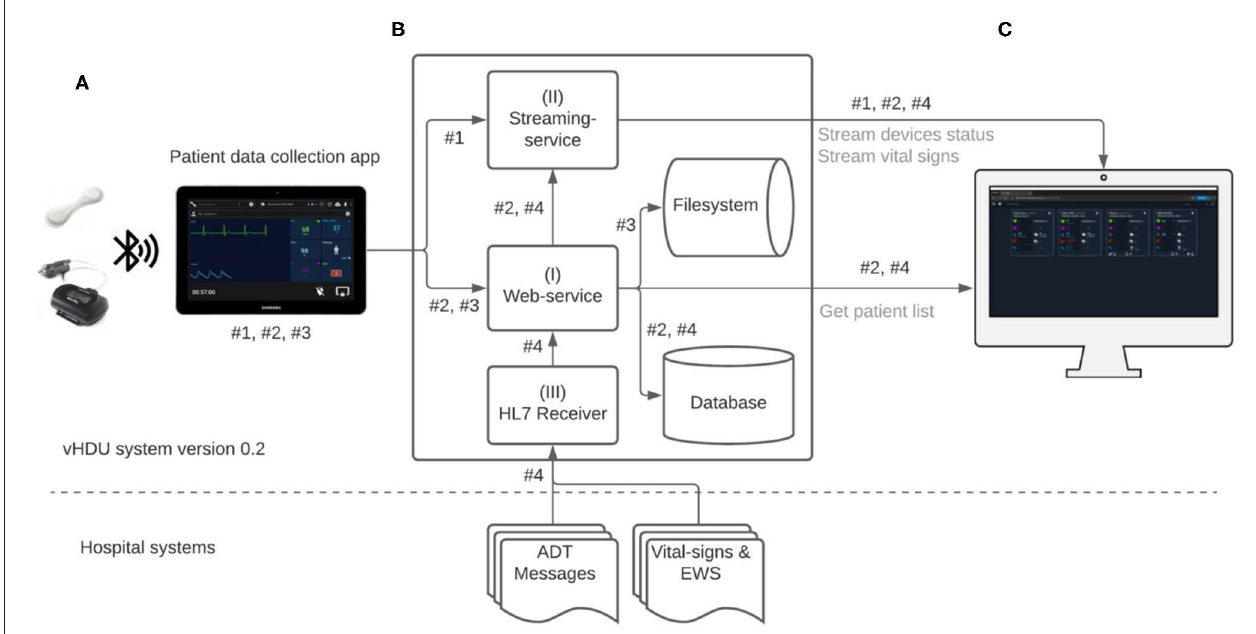
FIGURE 2 | Virtual High-Dependency Unit (vHDU) system version 0.2 data-flow diagram. Components: (A) the Patient data collection tablet app, which retransmits the wearables data to the back-end; (B) the Web-application back-end, which stores and relays that information to (C) the Clinician Dashboard client, which displays the data from remote locations ( via a web-browser). The main app datastreams of this system are: #1 - high-rate vital-sign values sent from the app to the streaming-service, each 2s; #2 - high-rate 10-s median vital-sign values and the most recent wearable status values, sent each 10s to the web-service, and low-rate 5-min vital-sign median values, sent each 5min to the web-service; #3 - compressed files (ZIP format) with the wearables raw-data, sent to the web-service; #4 - HL7 (Health Level Seven standard) messages with e-obs chart data and patient Admission-Discharge-Transfers (ADT) information, which are sent from the hospital systems into a HL7 receiver application on the vHDU back-end. Data transmission from both the VitalPatch ® and Nonin devices to the tablet app is encrypted using the Advanced Encryption Standard (AES) algorithm, over Bluetooth-Low-Energy. Data communication between the tablet app and the back-end web- and streaming-services, and between the latter and the Clinician Dashboard is encrypted using the Secure Sockets Layer (SSL) algorithm over the HTTPS and the secure Websockets protocols (for the web- and streaming-services, respectively). EWS, (local) Early Warning